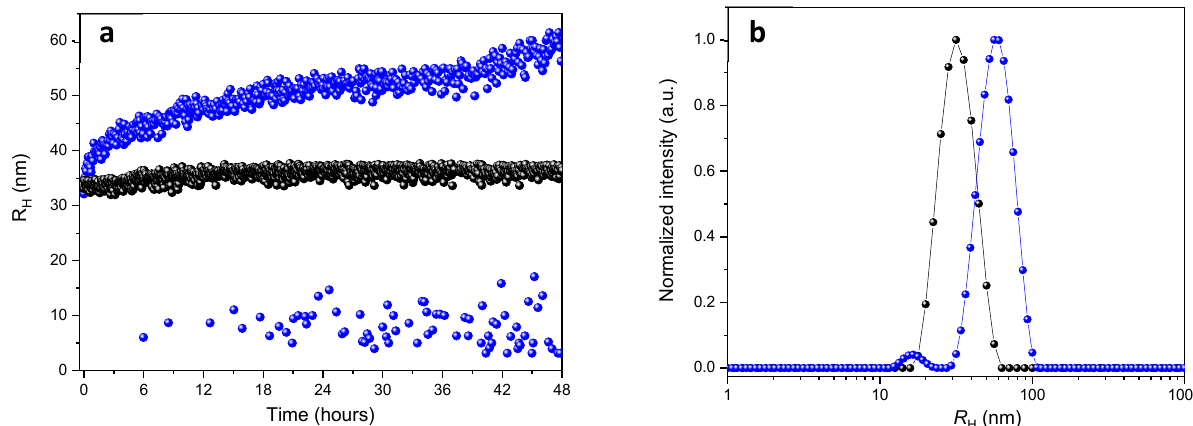
The DLS data from NPs measurements over 48 h at pH ~7.4 and ~5.0 are depicted in Figure 3. The DLS data clearly demonstrated that the hydrodynamic radius ( R H ) of NPs remains unchanged at pH ~7.4 for 48 h (black circles, Figure 3a), whereas it continuously increased at pH ~5.0 over the 48 h (blue circles, Figure 3a). Additionally, we also observed the appearance of a scattering population that increased over time, that corresponded to smaller sizes fraction with R H ~2 to 15 nm (blue circles, Figure 3a). A representative average intensity distribution of the NPs after 48 h at pH ~7.4 and ~5.0 are shown in Figure 3b. In contrast to the unimodal average size distribution of the NPs at pH ~7.4 (black circles, Figure 3b), the NPs average size distribution at pH ~5.0 is bimodal and shows two main population of particles with R H ~15 nm and R H ~58 nm (blue circles, Figure 3b), respectively.